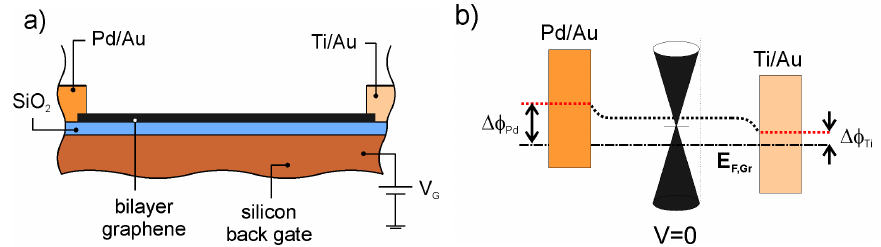
Figure 2. ( a ) Schematic of a bilayer graphene photodetector (PD) with asymmetric metal contacts; ( b ) schematic of the band structure of the device in (a) (after [37]). Graphene PDs have been integrated into silicon waveguides in a process compatible with Si complementary metal oxide semiconductor (CMOS) technology for potential applications as on-chip optoelectronic couplers [51,52] or modulators [53]. This concept was further explored by Schall et al., who successfully demonstrated waveguide-integrated CVD graphene PDs with a bandwidth of 41 GHz and an extrinsic response of 16 mAW − 1 [54]. The detection of data signals up to 50 Gbit·s − 1 is comparable to the performance of state-of-the-art germanium-based Si waveguide-coupled PDs [32,55]. A similar graphene/Si waveguide-integrated PD by Wang et al. exhibits a sensitivity of 0.13 mAW − 1 at mid-IR wavelengths ( λ = 2.75 µm). Here, the SR was described by a combination of the PTE and the PVE [25].